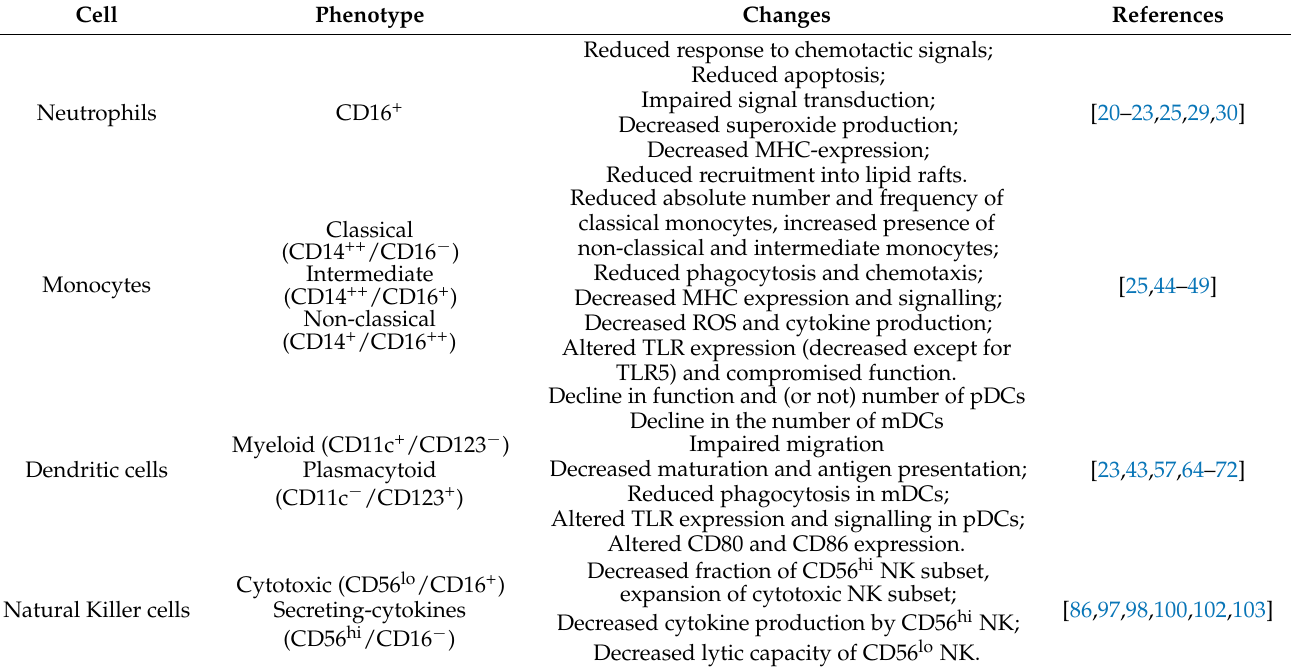
Table 1. Age-associated changes in innate immunity